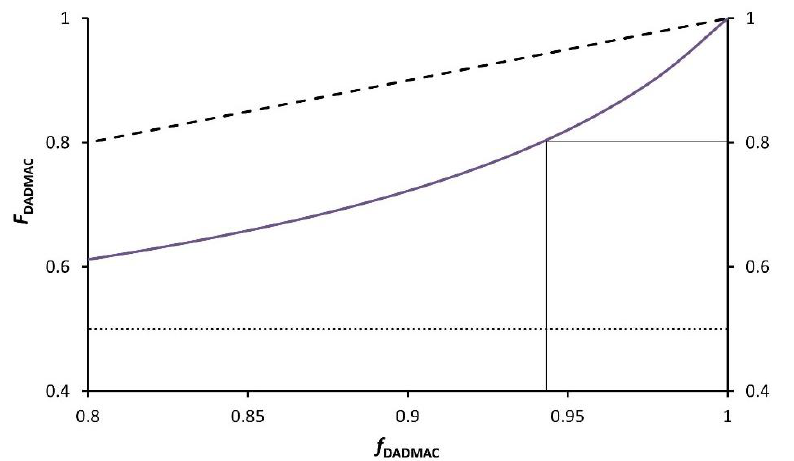
Figure 2. Extract of the calculated copolymerisation diagram of DADMAC with acrylamide, which is used as a substitute for BIS (the full diagram in shown in Figure S16 in the Supporting Information). The solid line indicates the calculated mole fraction of DADMAC in the polymer F DADMAC as function of the mole fraction in solution f DADMAC . The dashed line shows the polymer composition for the statistical copolymerisation and the dotted line the alternating type. The latter are for reference only. The marks indicate the example containing 3 mol% BIS mentioned in the text.